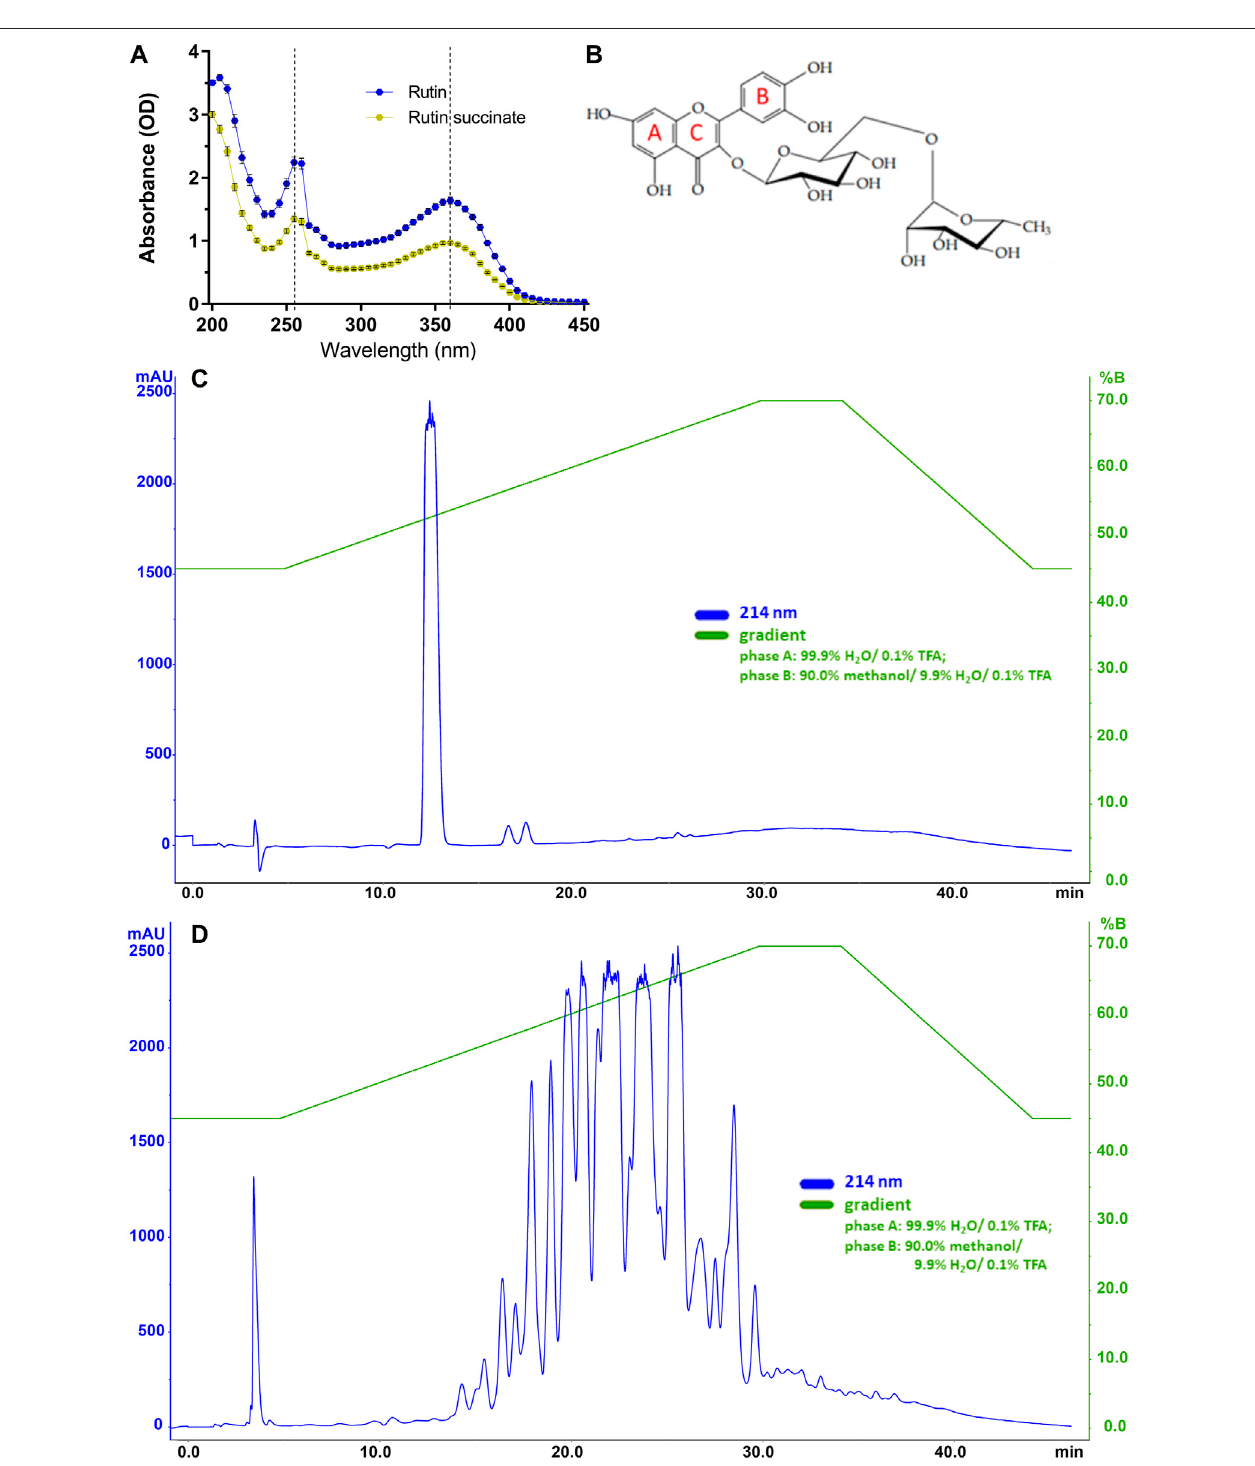
FIGURE 2 | (A) The absorbance spectra of rutin and RS. (B) Molecular structure of rutin with indications of aromatic rings A, B and C; Chromatographic pro fi les obtained for (C) rutinand (D) RSanalyzed byHPLC usingaC18column (250 ×4.6 mm). Chromatographicconditions:ACE C18column (250 ×4.6 mm);mobilephase A: 99.9% H 2 O/0.1% TFA and B: 90.0% methanol/9.9% H 2 O/0.1% TFA); fl ow rate of 1.0 ml/min; λ = 214 nm; and injection volume of 20 μ l.